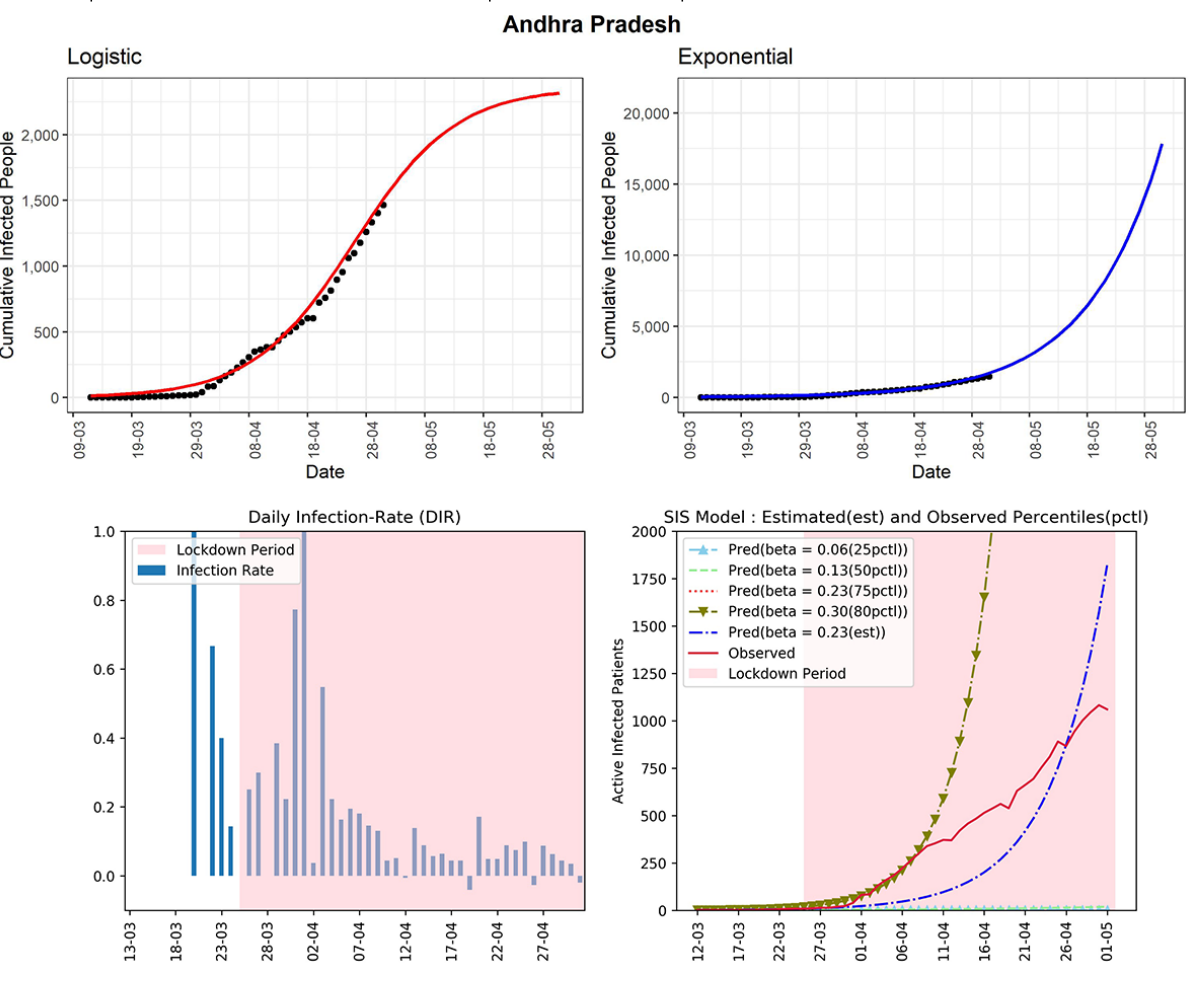
Figure 12. Graphs for the state of Andhra Pradesh. SIS: